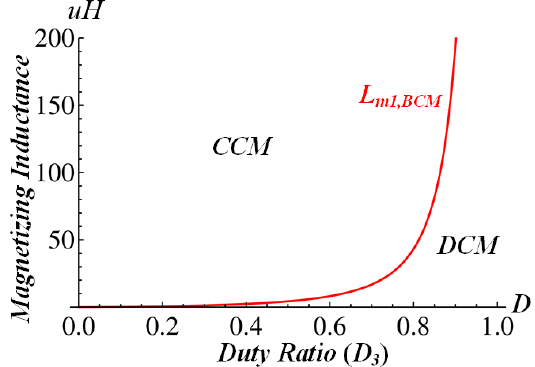
Figure 11. Curve of L m 1 ,BCM in step-down mode.